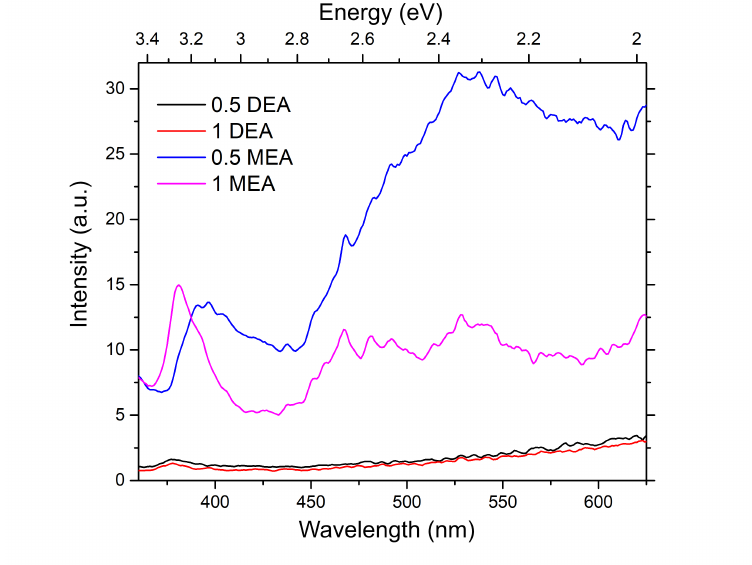
Figure 15. Photoluminescence of samples grown on